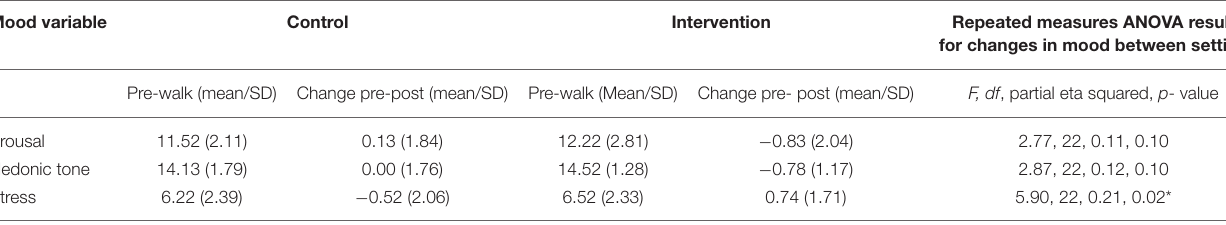
for changes in mood between setting